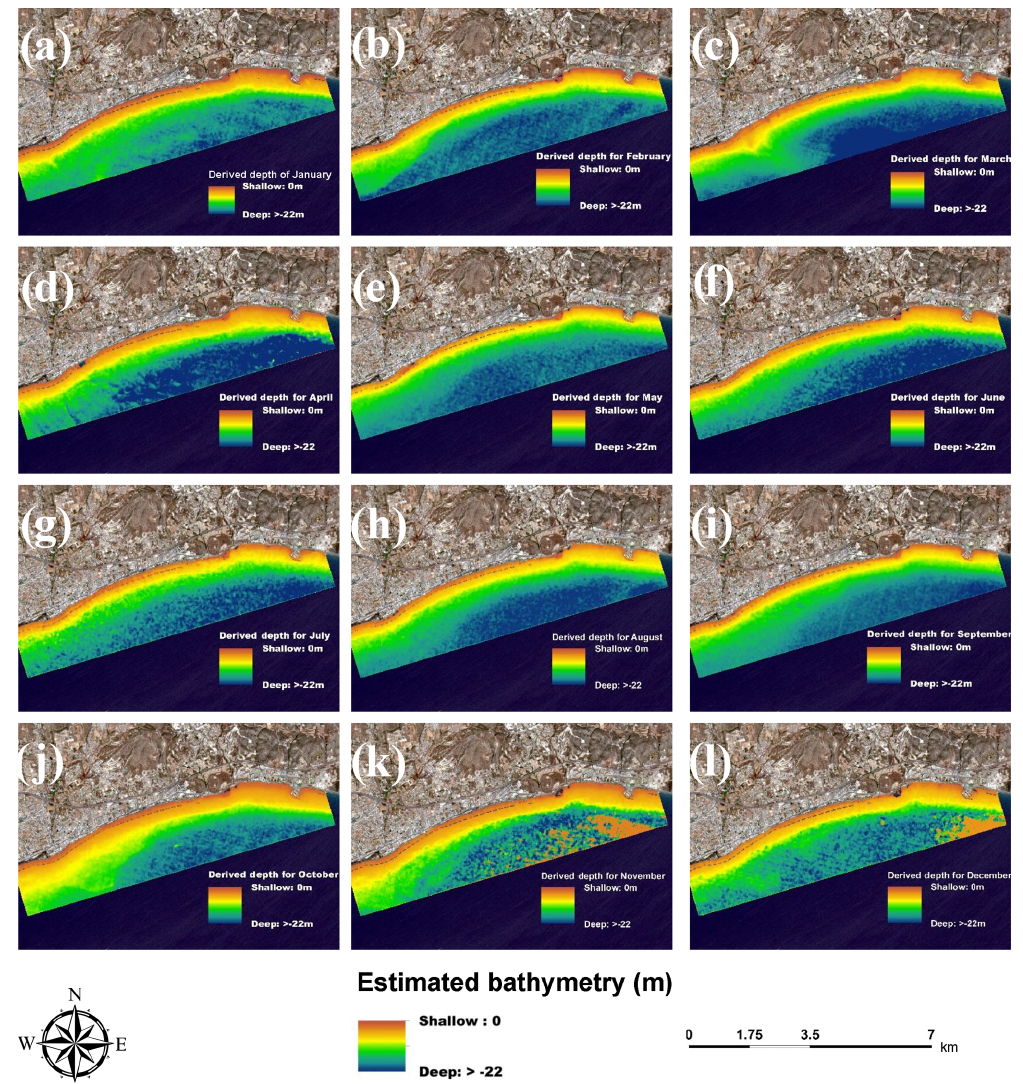
Figure 5. Predicting and mapping SDB with ranges 0 to − 22m depth, for the months (a) January, (b) February, (c) March, (d) April, (e) May, (f) June, (g) July, (h) August, (i) September, (j) October, (k) November , (l)